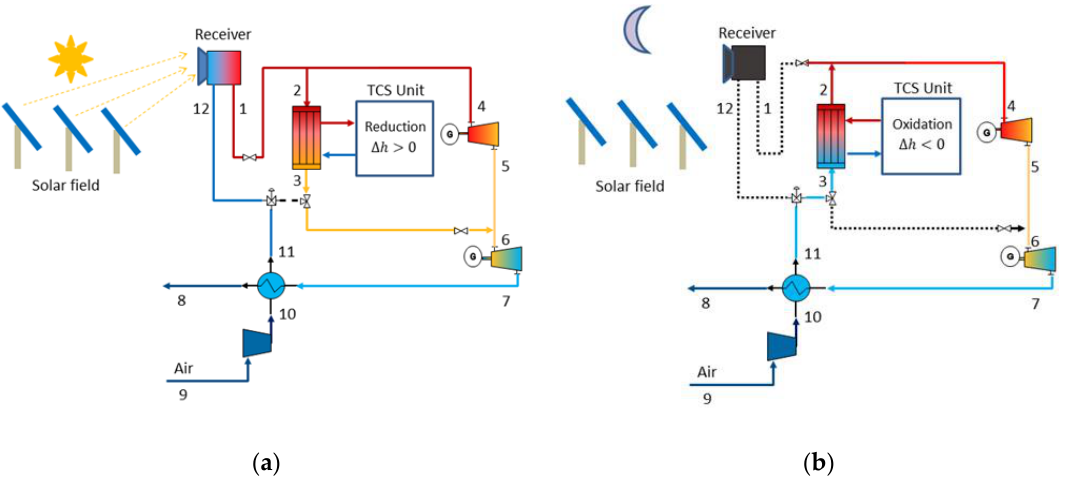
Figure 12. Indirect integration scheme for a central tower plant/TCS unit (oxide systems)/power block: ( a ) on-sun operation; ( b ) off-sun operation.